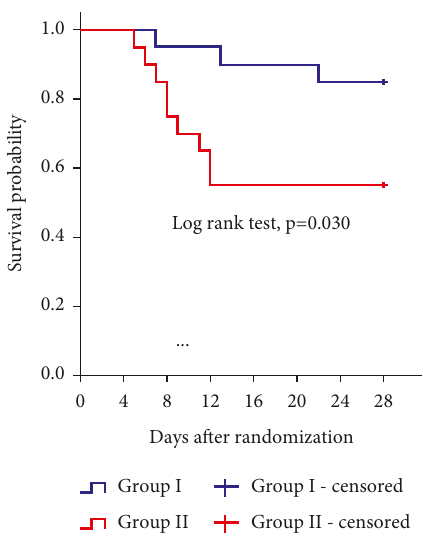
Figure 4: Kaplan–Meier plot for 28-day